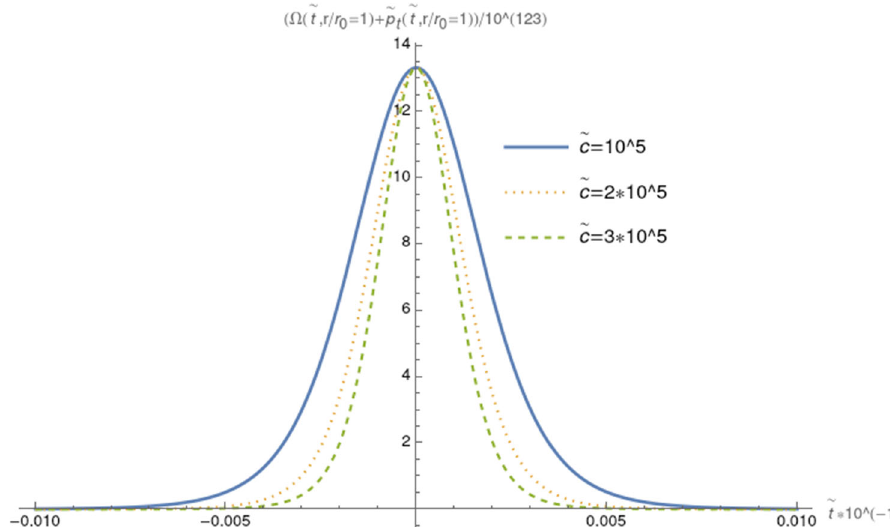
Fig. 3 Here we present the component (cid:9) + p t , divided by factor 10 123 , at the throat, r = r 0 = 10 − 2 / H 0 , for different values of the parameter ˜ c . We also assumed (cid:7)( r , t ) =